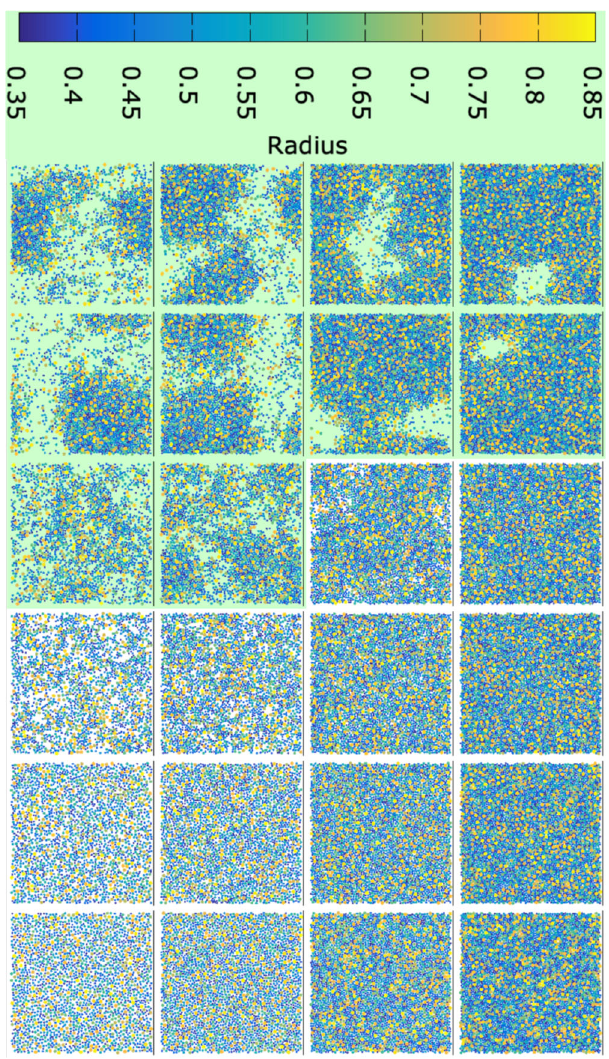
Fig. 1 Representative stationary con fi gurations. The packing fraction increases from left to right ϕ ≃ 0.4, 0.5, 0.7, 0.8. The persistence length increases from bottom to top ℓ = 0.01, 0.1, 1, 10, 50, 200. Particle colors indicate their radius (increasing values from violet to yellow). For large persistence lengths, the system undergoes Motility-Induced phase separation (MIPS) (snapshots with green background). The MIPS region extends to large packing fractions, i.e., ϕ ≃ 0.8. In the dense regime, the system behaves as a glass at small persistence lengths, then melts to a fl uid state, and fi nally undergoes